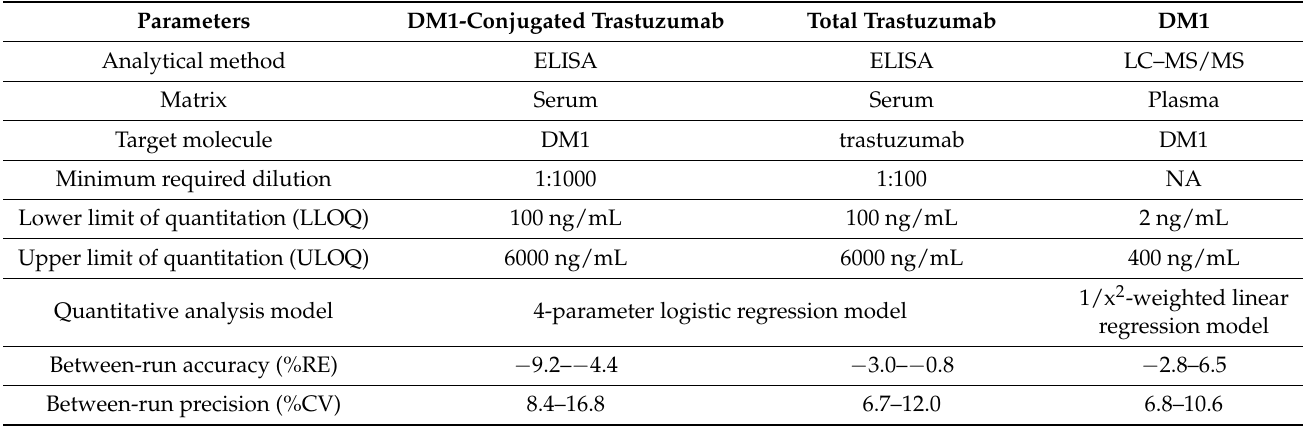
Table 1. Validated bioanalytical parameters for quantification of